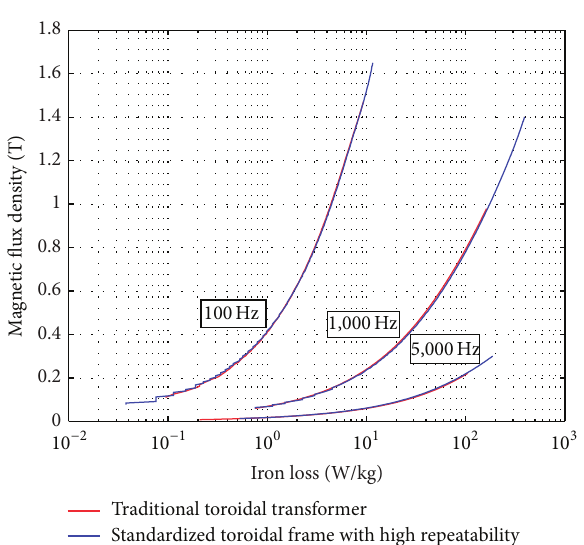
Figure 13: Measurement results obtained at 60 Hz.